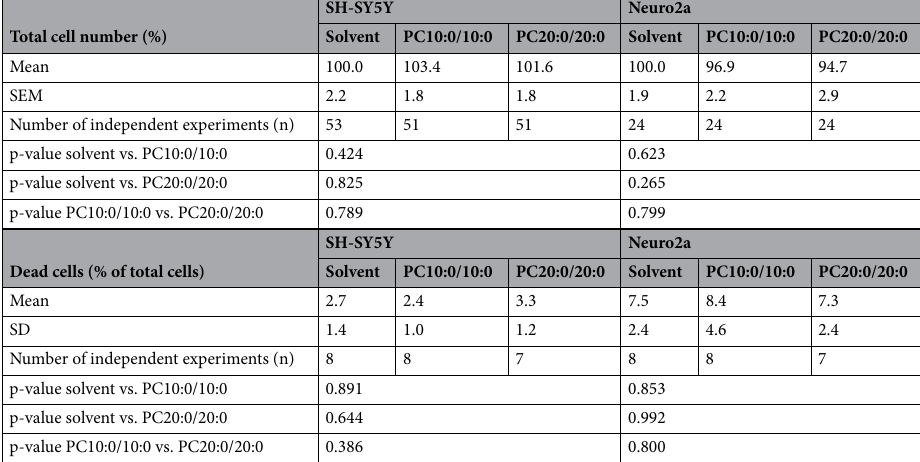
(Table 1). Thus, the observed effects of PC10:0/10:0 on H 2 O 2 release and intracellular ROS levels cannot be traced to alterations in the proliferation or viability of the used cells.